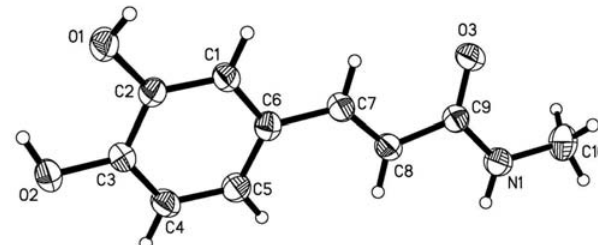
Table 1. Data collection and handling.